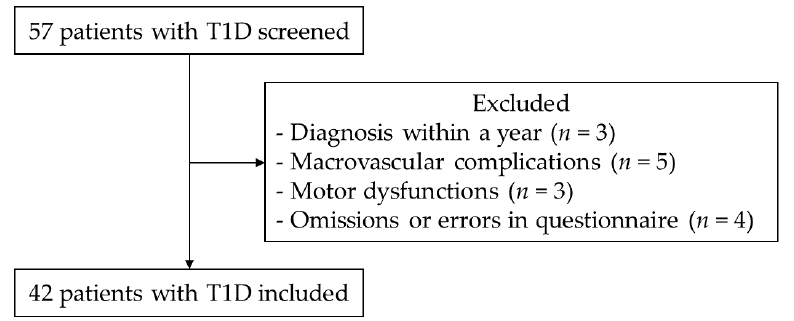
Figure 1. Patient screening flowchart. T1D: type 1 diabetes.